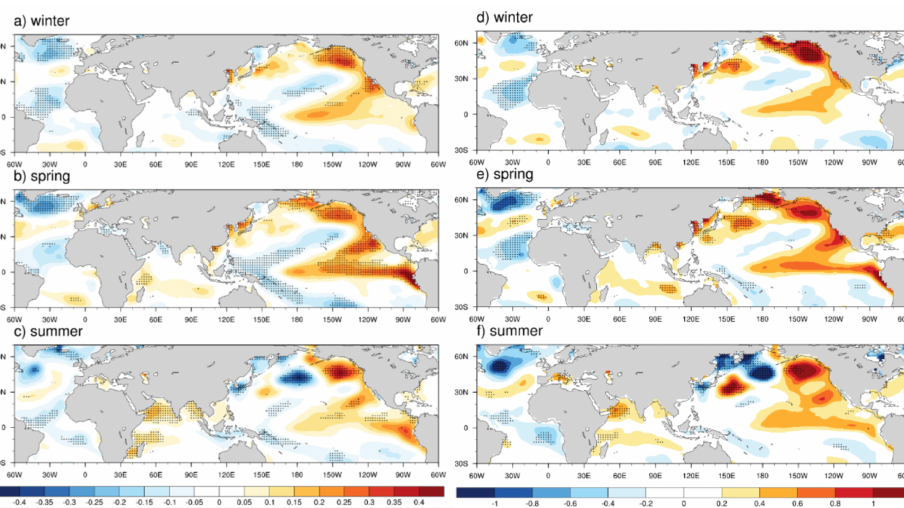
Figure 11. Regression maps ( a – c ) of sea surface temperature (SST) onto PC1. The difference maps ( d – f ) of the same elements between the five most positive years and the five most negative years in PC1. Stippled areas indicate anomalies and differences that exceed the 90% confidence levels. Units: ◦ C.